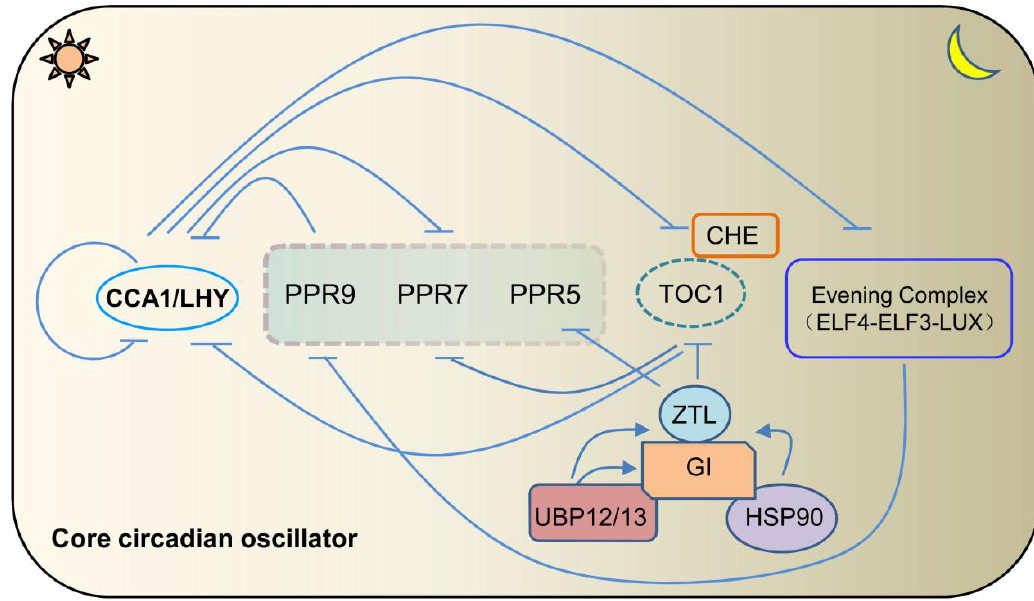
Figure 1. A simplified model for the circadian clock in Arabidopsis thaliana . Morning expressed CIRCADIAN CLOCK-ASSOCIATED1 (CCA1) and LATE ELONGATED HYPOCOTYL (LHY) repress the expression of all of the PRR family members and evening complex (EC). All the PSEUDO-RESPONSE REGULATOR (PRRs) reciprocally repress the expression of CCA1 and LHY . EC is composed by EARLY FLOWERING 4 (ELF4), EARLY FLOWERING 3 (ELF3), and LUX ARRHYTHMO (LUX), and acts as a negative regulator of PRR9 . GIGANTEA (GI) acts as a co-chaperone, recruiting HSP90 for the maturation of the ZEITLUPE (ZTL) protein. Additionally, GI recruits the deubiquitylases, UBP12 and UBP13, to regulate the accumulation of ZTL photoreceptor complex.